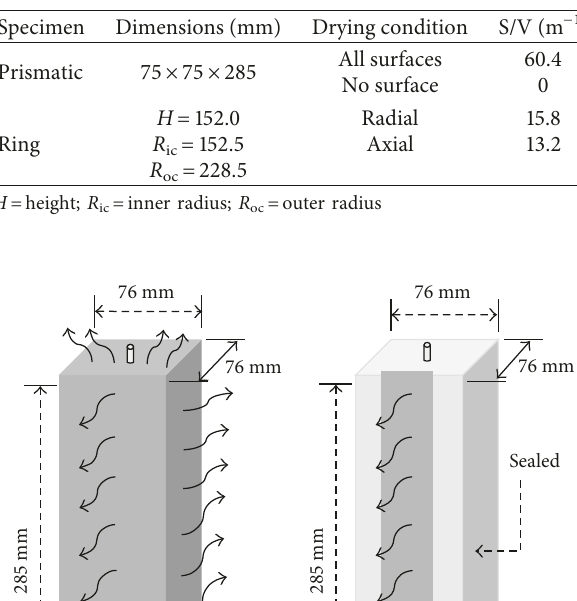
Table 2: Dimensions and S/V ratios of specimens.